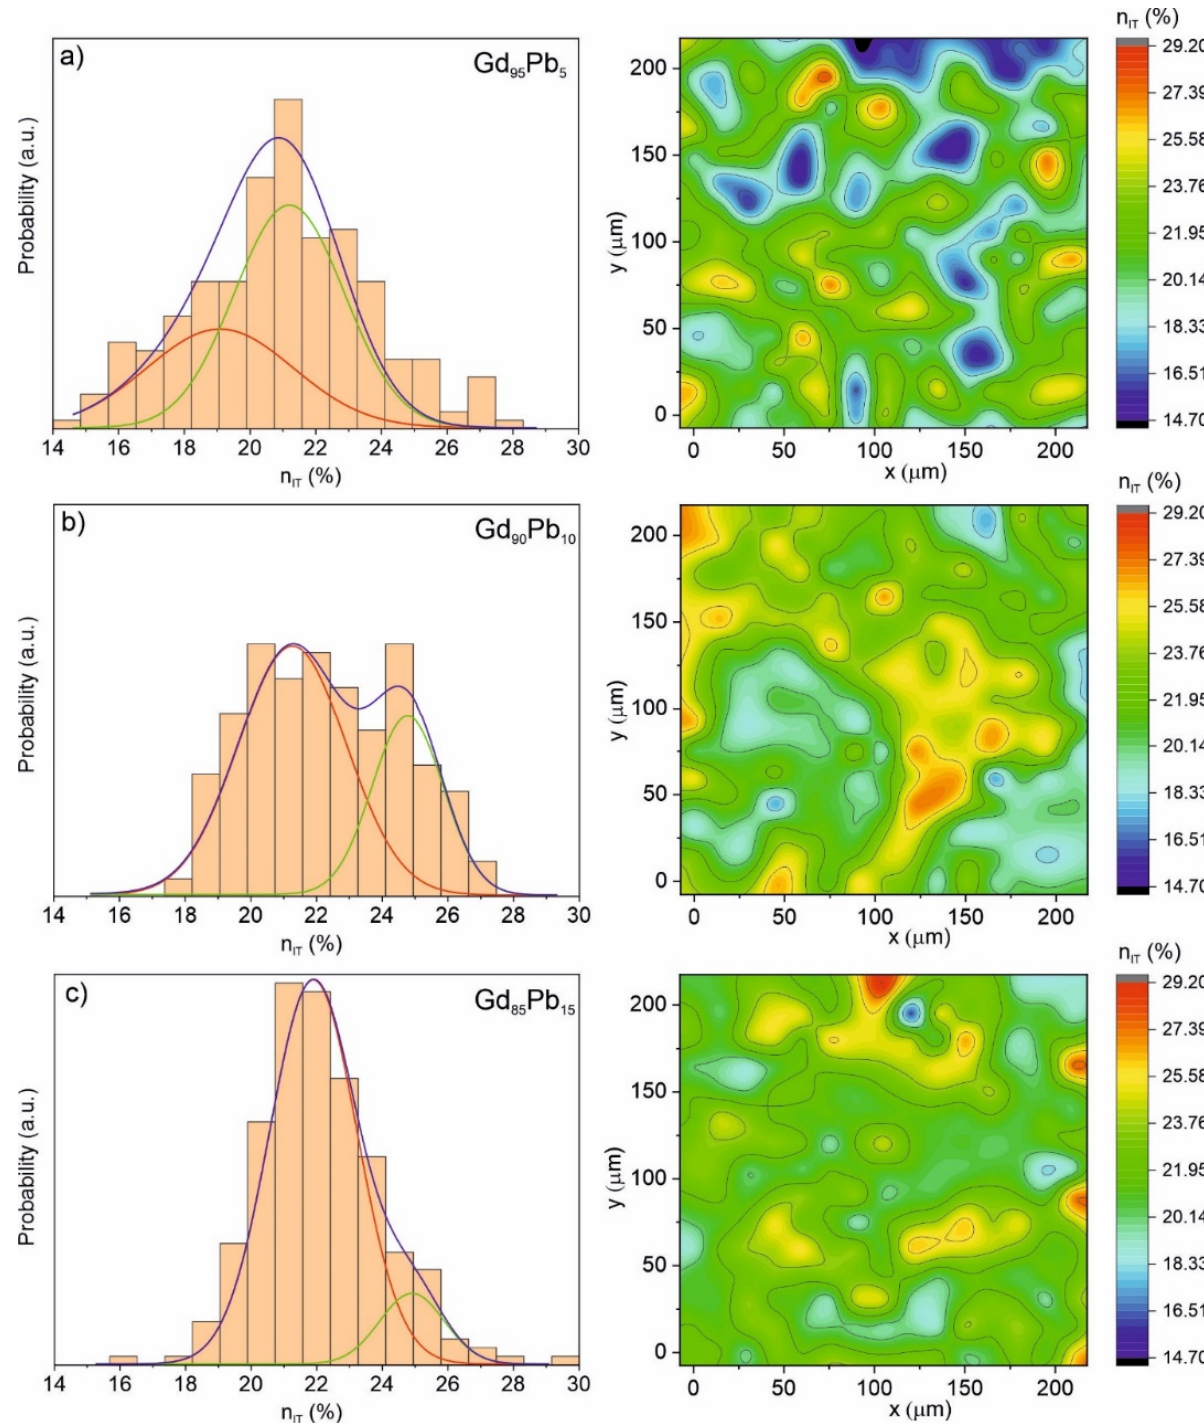
Figure 10. Distributions of elastic to total deformation energy n IT with corresponding 2D mapping graphs obtained from nanoindentations test for the Gd 95 Pb 5 ( a ), Gd 90 Pb 10 ( b ) and Gd 85 Pb 15 ( c ) alloys. Table 6. Hardness (HV IT ), Young’s modulus (E IT ) and elastic to total energy deformation ratio (n IT ) for the individual phases observed in the Gd 95 Pb 5 , Gd 90 Pb 10 and Gd 85 Pb 15 alloys.